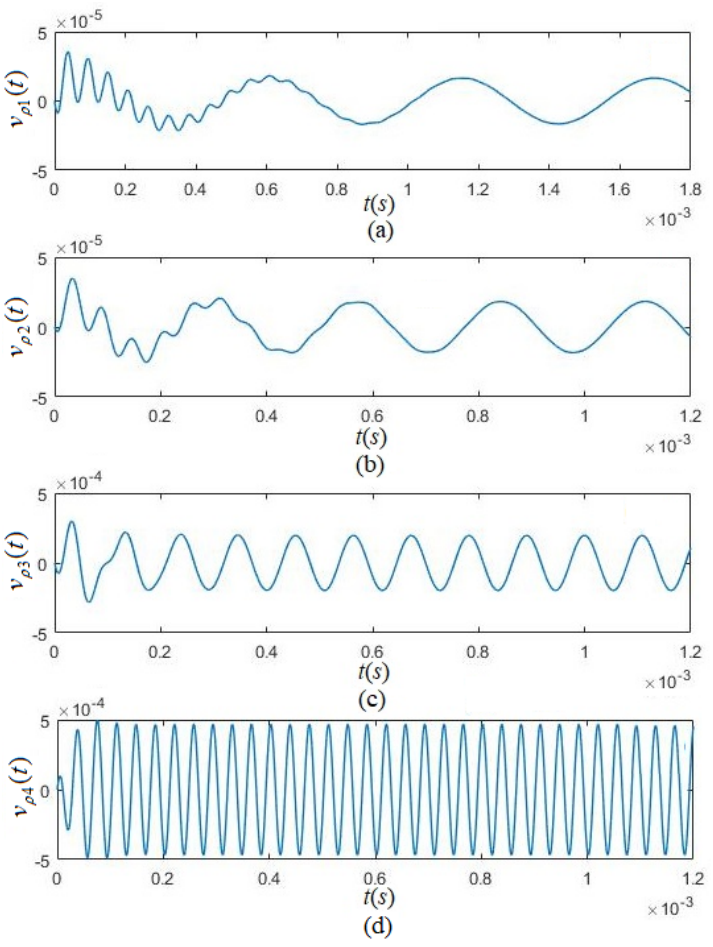
Figure 9. The convolution of the sinusoidal frequency components selected from the gated sinusoi-